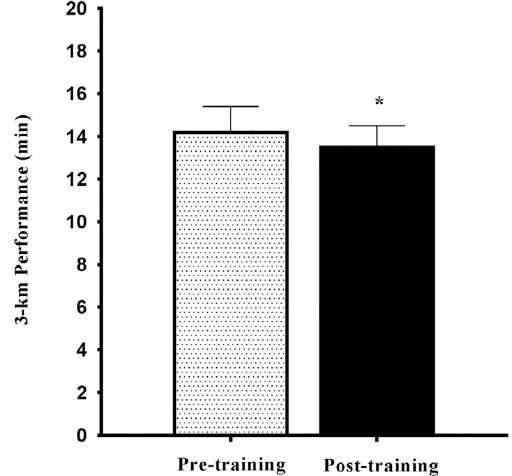
Figure 1 - Time to complete the 3 km FR performance (min) at pre-and post-training (mean ± SD). * P < 0.05 in relation to pre-training.